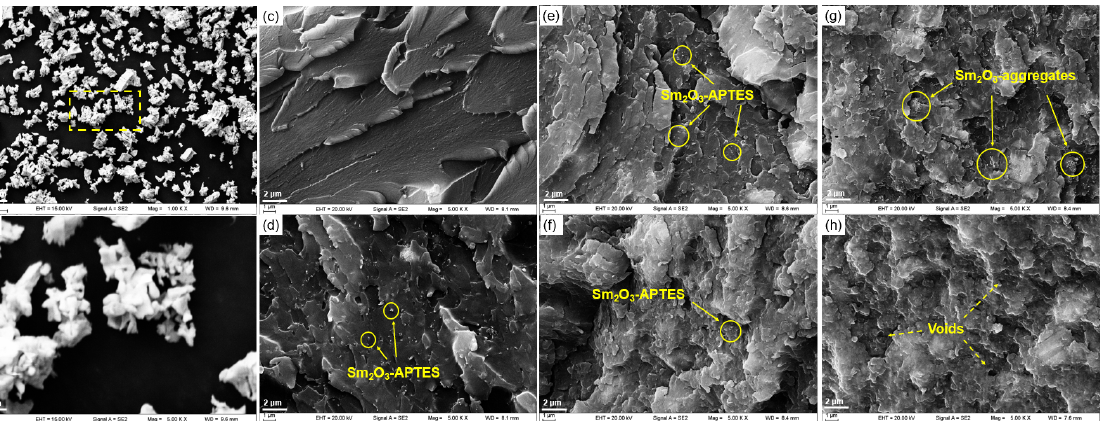
Figure 6. SEM images of Sm 2 O 3 -APTES particles and morphology of Sm 2 O 3 -APTES/AFG-90H: ( a , b )